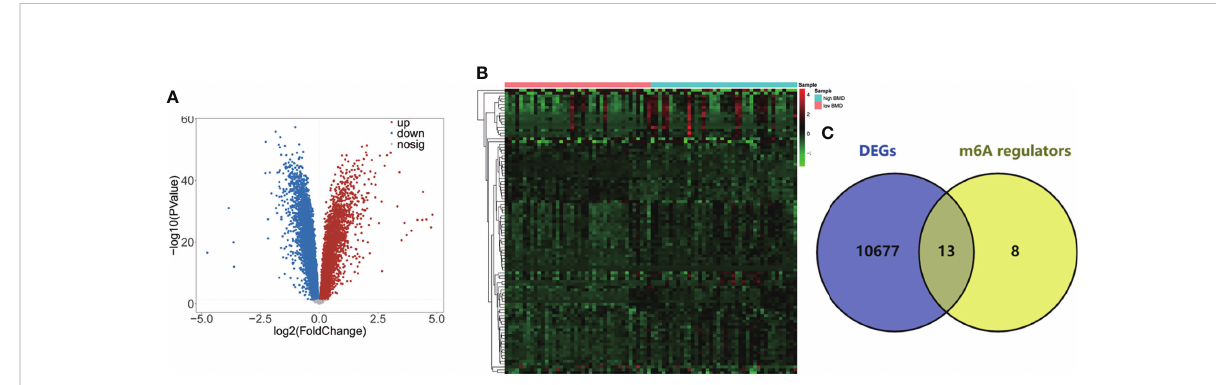
FIGURE 2 Identi fi cation of the 13 DE-m6A regulators. (A) Volcano plot showing the DEGs between high-BMD women ( n = 40) and low-BMD women ( n = 40) in the GSE56815 dataset. (B) Heatmap indicating the top 100 DEGs between high-BMD women ( n = 40) and low-BMD women ( n = 40) in the GSE56815 dataset. (C) Venn plot showing the DE-m6A regulators between high-BMD women ( n = 40) and low-BMD women ( n = 40) in the GSE56815